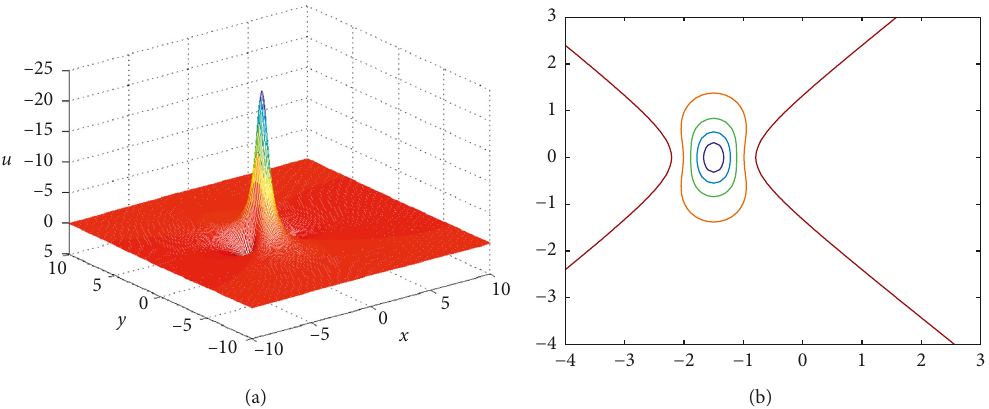
Figure 1: (a) Plots of lump solutions (8) with α